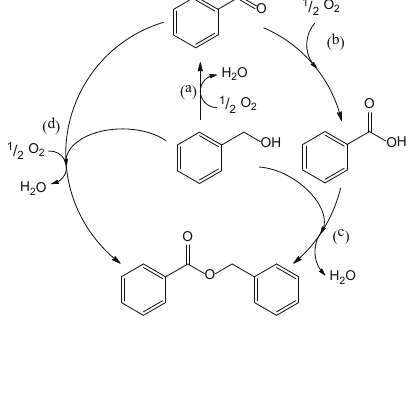
Figure 1. Reaction network: ( a ) oxidation of benzyl alcohol to benzaldehyde; ( b ) oxidation of benzaldehyde to benzoic acid; ( c ) esterification of benzyl alcohol and benzoic acid, and ( d ) esterification of benzyl alcohol and benzaldehyde under oxidative conditions to benzyl benzoate